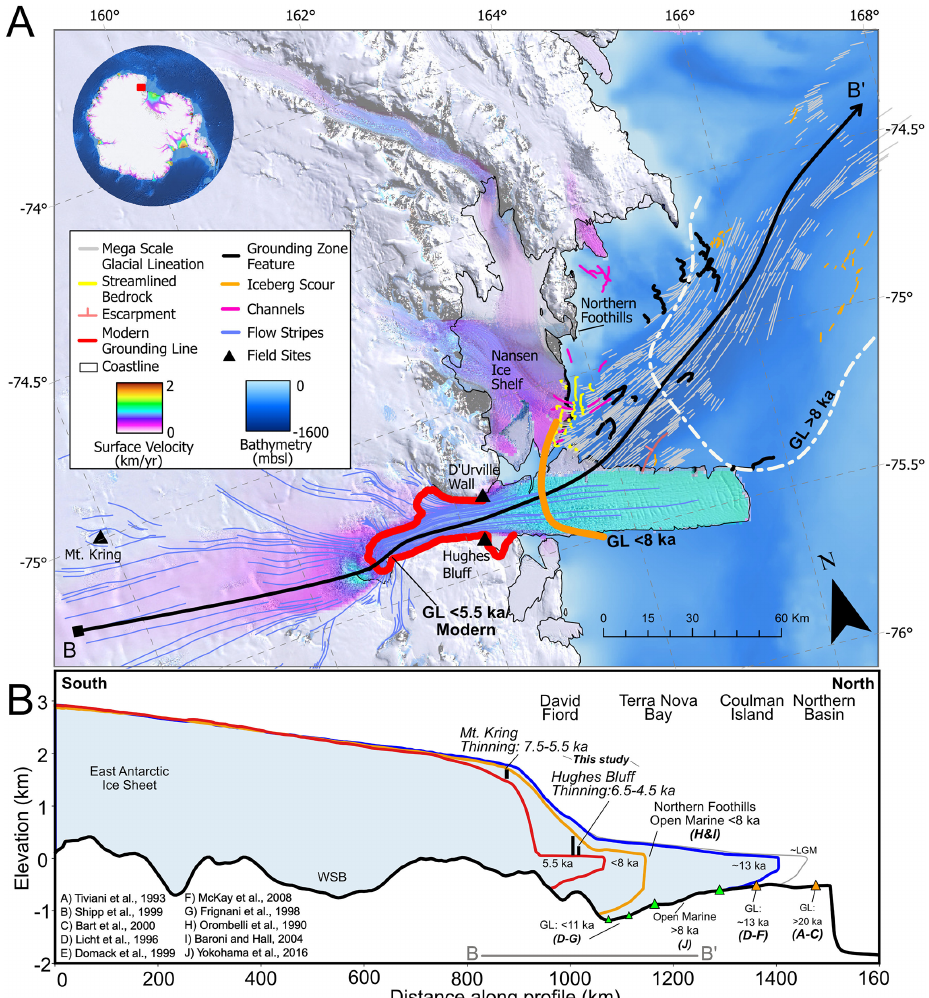
Figure 12. (a) Map of David Glacier, Terra Nova Bay and surrounding areas. Synthesis map focused on two-phase retreat between > 8 and 5.5ka, including geographic and geomorphic features mentioned in text. Ice surface velocity of Rignot et al. (2011) and LIMA satellite data of Bindschadler et al. (2008). Inset with red box for main extent shows bathymetry of Arndt et al. (2013) and ice surface velocity of Rignot et al. (2011). (b) Synthesis profile focused on two-phase retreat between 11 and 5.5ka. Grounding zone features: triangles with age constraints (orange), triangles without age constraints (green) of Lee (2019). GL: grounding